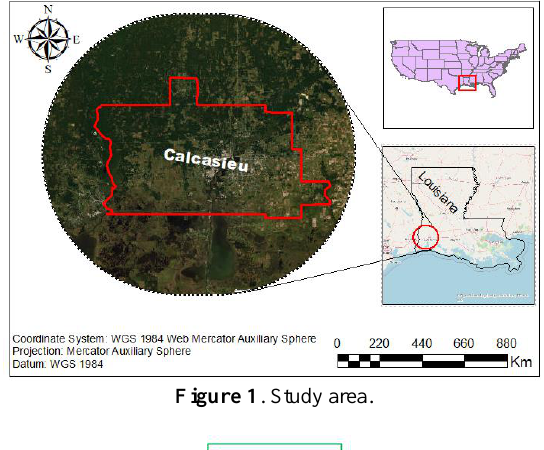
Figure 1 . Study area.